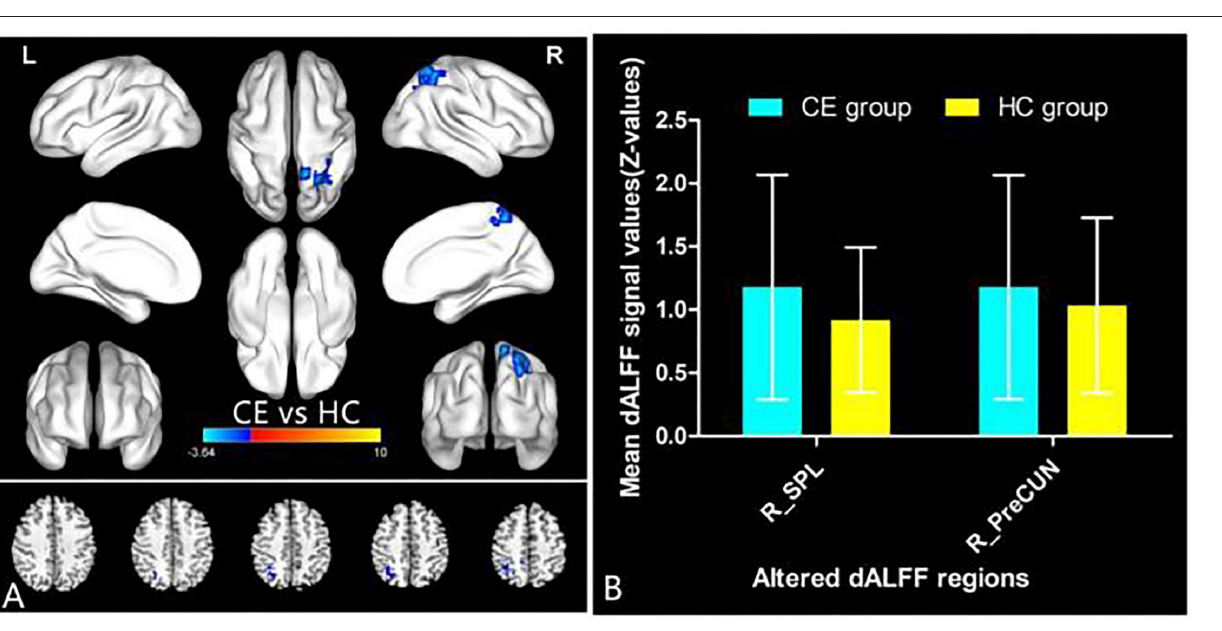
Frontiers in Human Neuroscience |